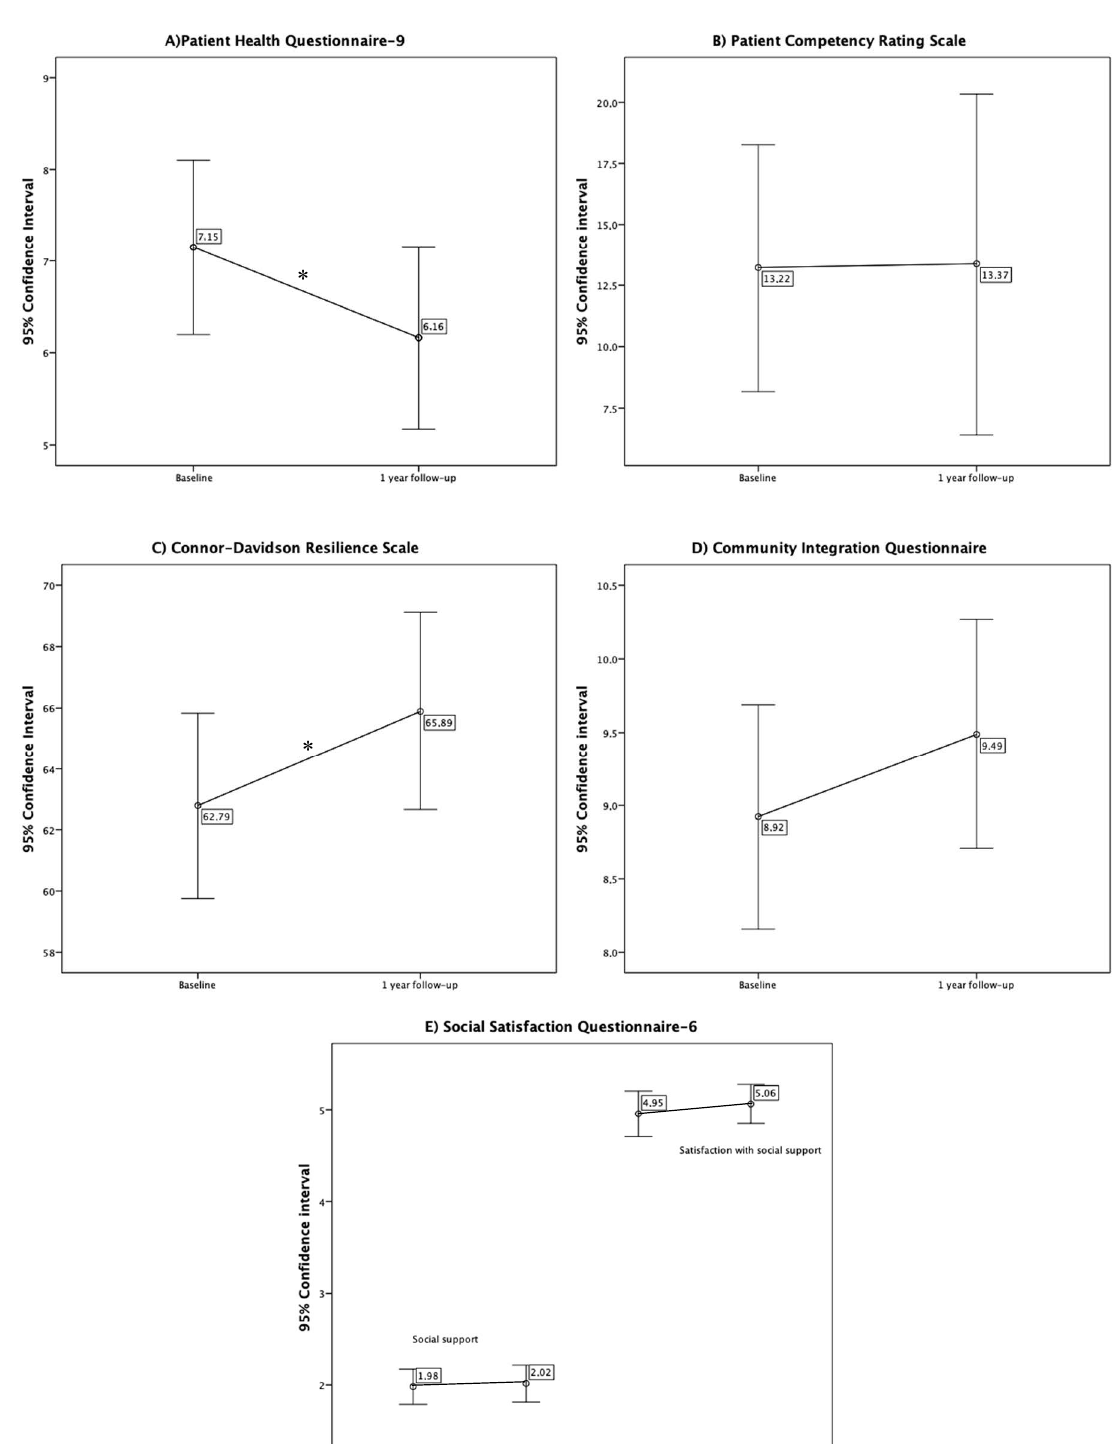
Figure 1. Confidence interval plots for the scores in ( A ) Patient Health Questionnaire-9 (PHQ9), ( B ) Patient Competency Rating Scale (PCRS), ( C ) Connor–Davidson Resilience Scale (CD-RISC), ( D ) Community Integration Questionnaire (CIQ), and ( E ) Social Support Questionnaire-6 (SSQ6) in baseline and 1 year follow-up ( Note: * p < 0.05 in paired t -test analysis).